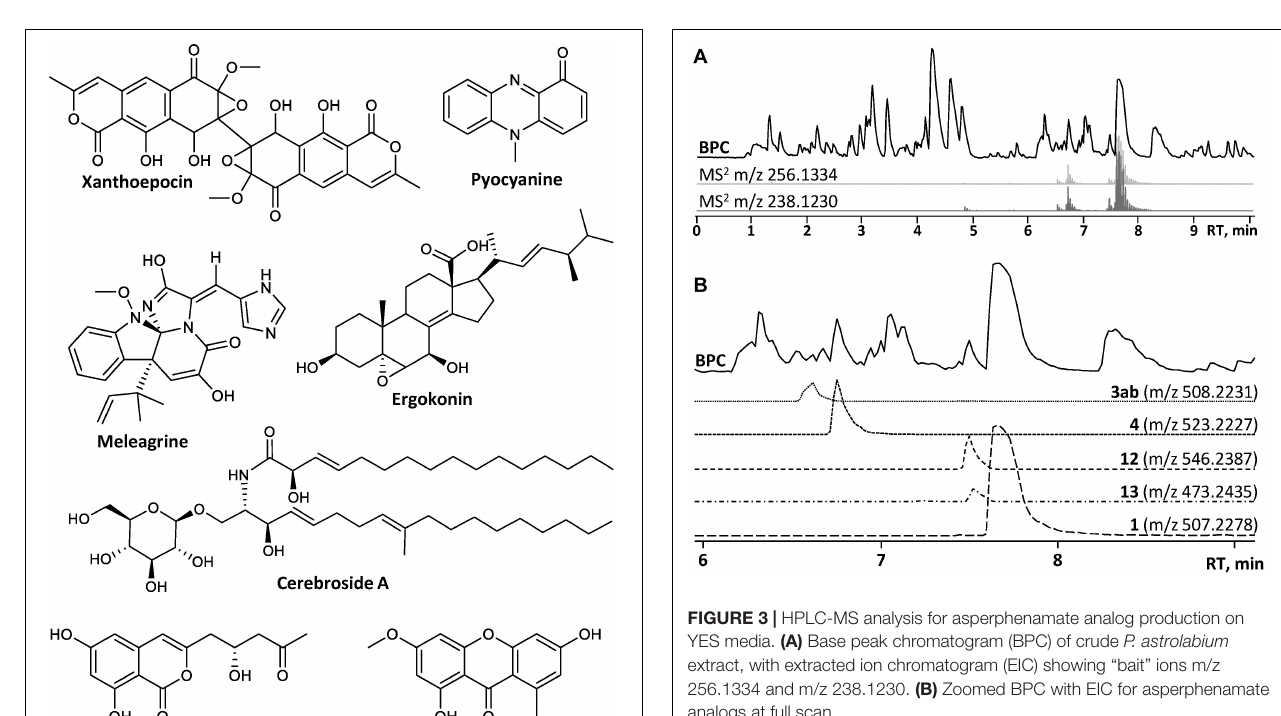
using standard sequence pulses. Samples were analyzed in a 3 mm TCl cryoprobe using deuterated chloroform (CDCl 3 ) and referenced to the residual solvent signals δ H = 7.26 ppm and δ C = 77.16 ppm. J-couplings are reported in hertz (Hz) and chemical shifts ( δ ) in ppm. For 1D and 2D NMR data, see